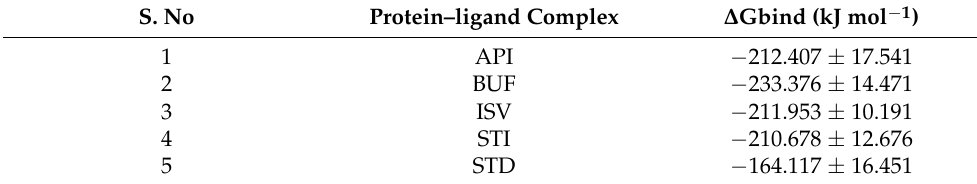
Table 6. MM/PBSA energy for top ranked complex.